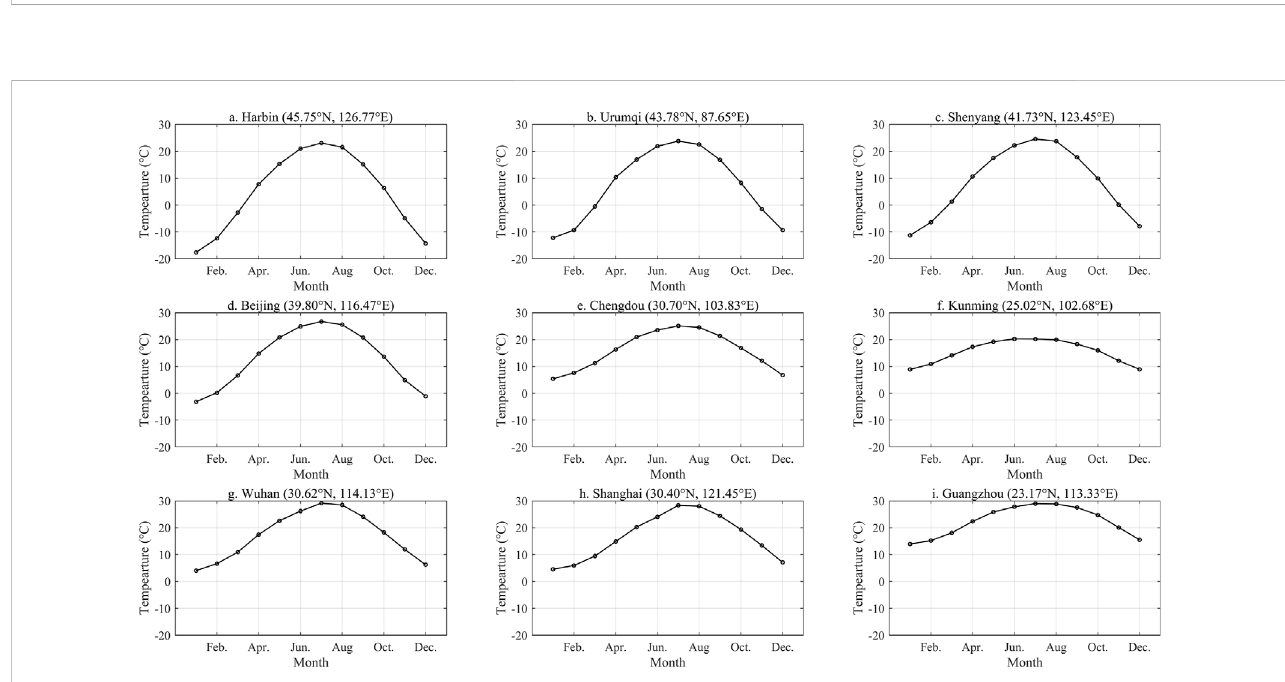
FIGURE 4 Multi-year monthly average temperature for nine cities during 1981 – 2010. Lables ( A – I ) represent nine cities, Harbin, Urumqi, Shenyang, Beijing, Chengdou, Kunming, Wuhan, Shanghai, Guangzhou,